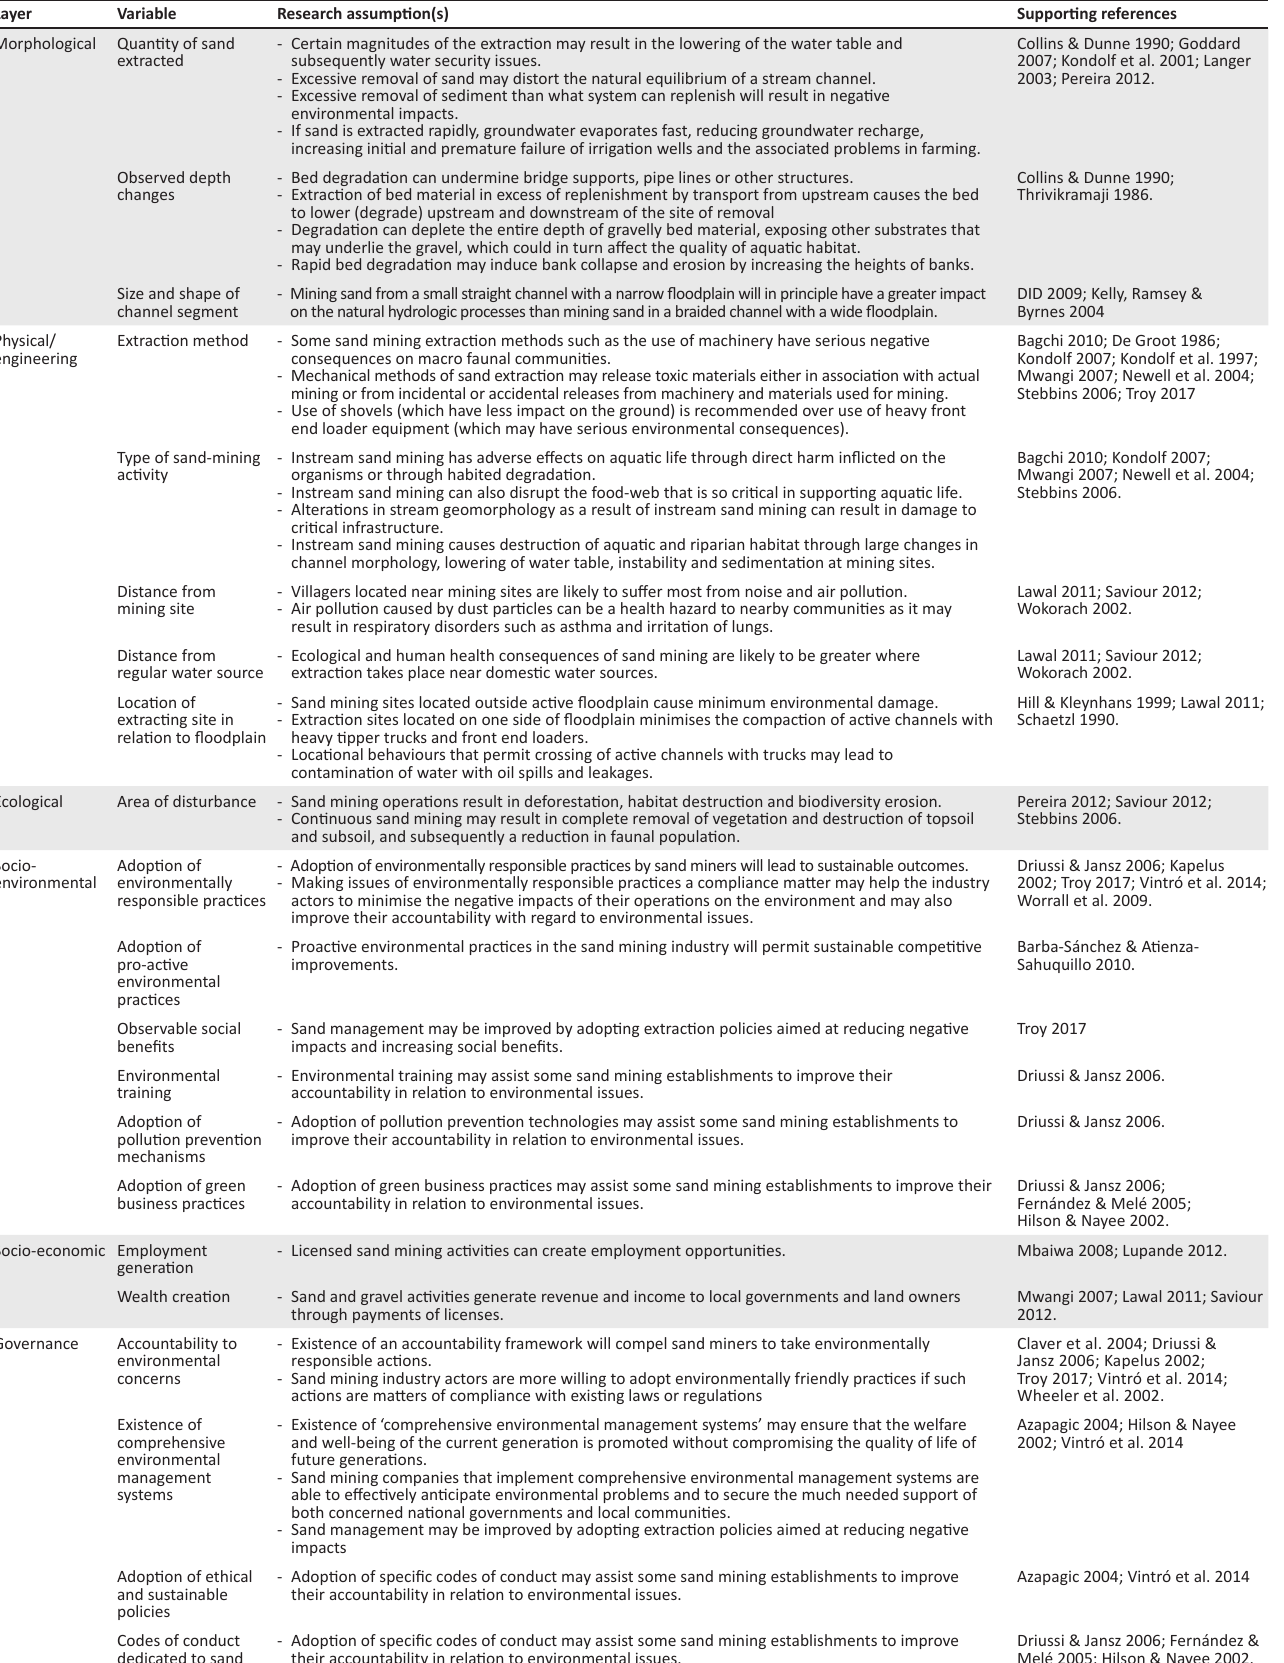
TABLE 1: Study variables and associated assumptions